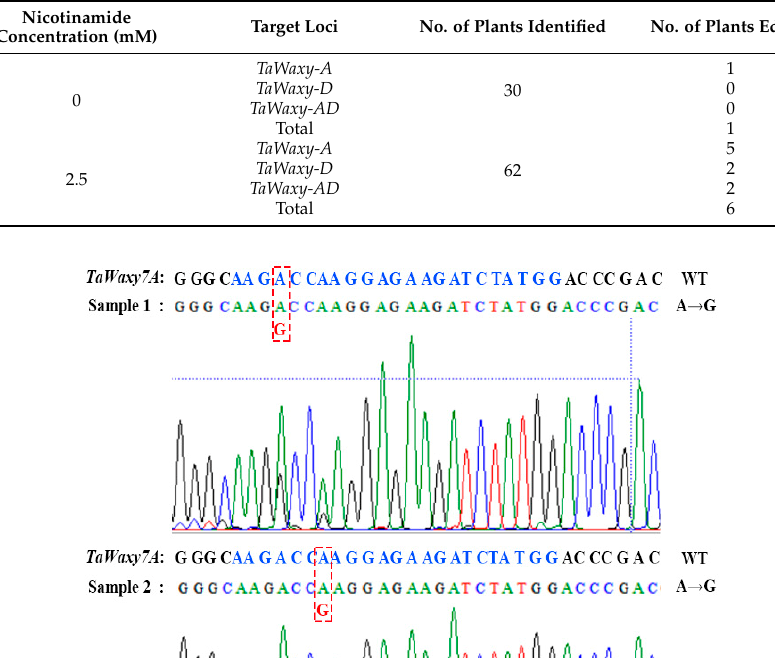
Table 6. The base editing efficiency of TaWaxy genes using nicotinamide treatment.